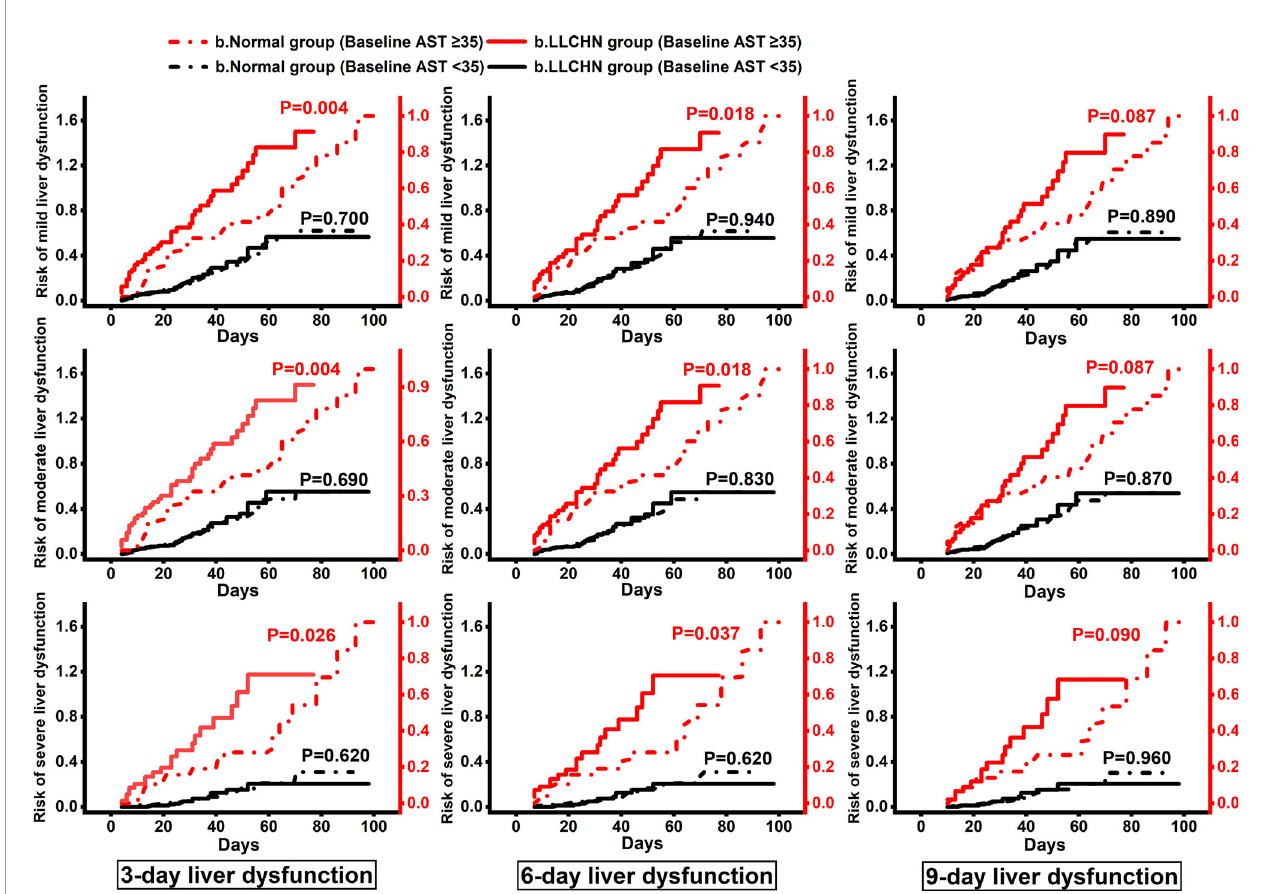
FIGURE 3 | Kaplan – Meier Curves for the cumulative risk of 3-, 6-, and 9-day liver dysfunction in the b.LLCHN group and the b.normal group. Kaplan – Meier curves were divided into two parts by the baseline levels of AST. Participants with the peak values of lymphocyte ratio ≤ 26.1 and neutrophil ratio ≥ 62.0 within 3 days of admission were classi fi ed as b.LLCHN group, and others were classi fi ed as b.Normal group. AST, aspartate transaminase; CI, con fi dence